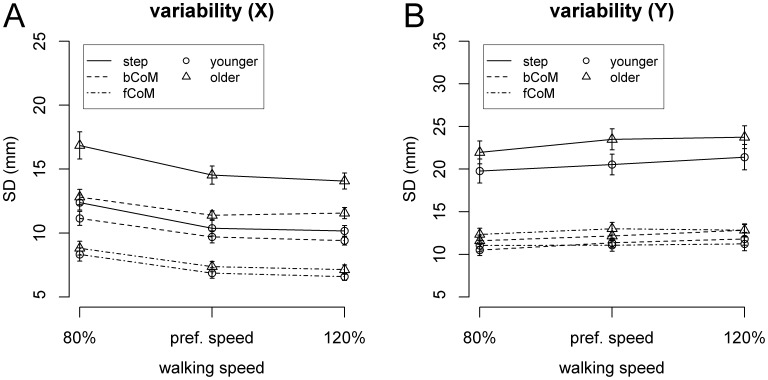
Empirical variability of task variables in fore-aft (A) and lateral (B) direction as a function of walking speed and age group.Variability is represented as standard deviation rather than variance, i.e. the square root of TV. Error bars represent SEM.